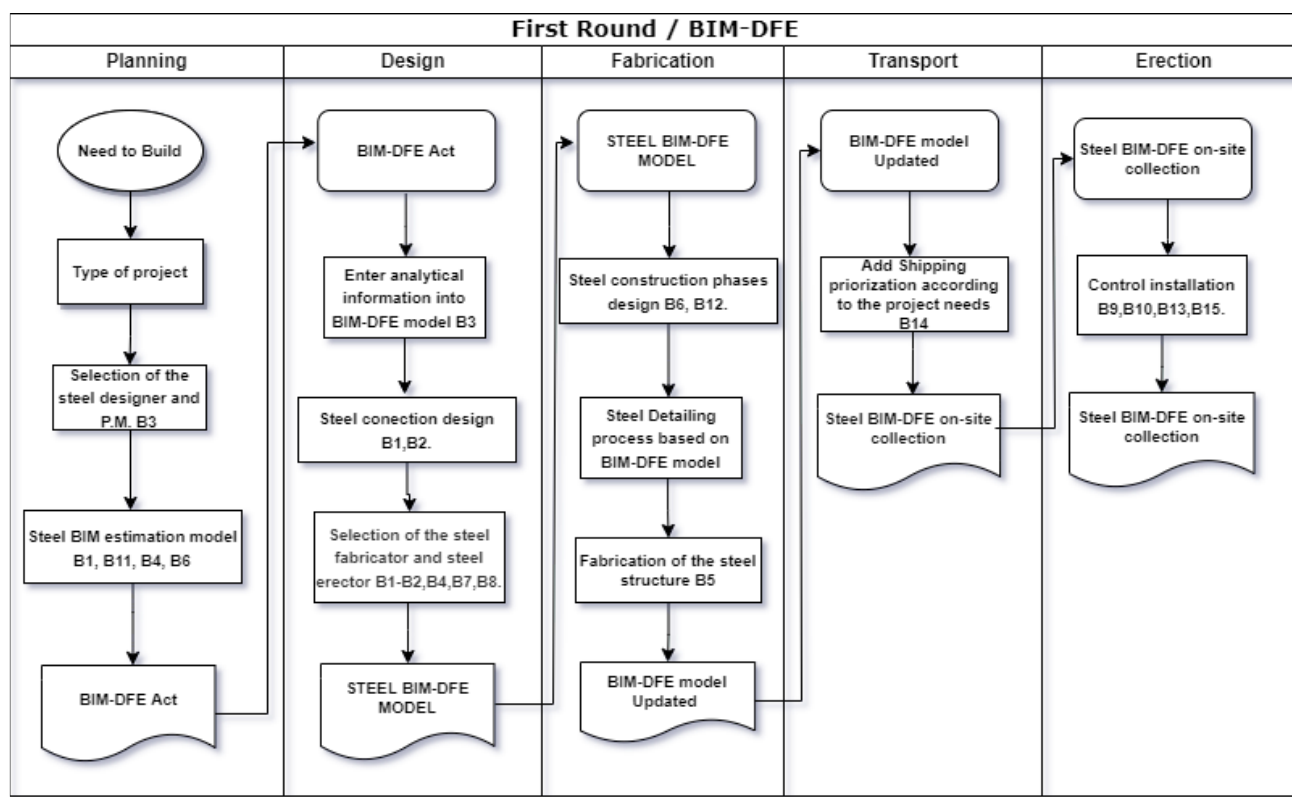
Figure 1. Preliminary integration of BIM in steel building projects (B# indicates the BIM uses from Table 1) .